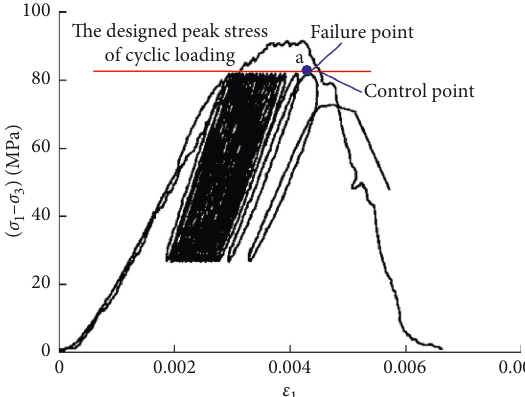
Figure 4: Diagram of the failure point and control point [22].